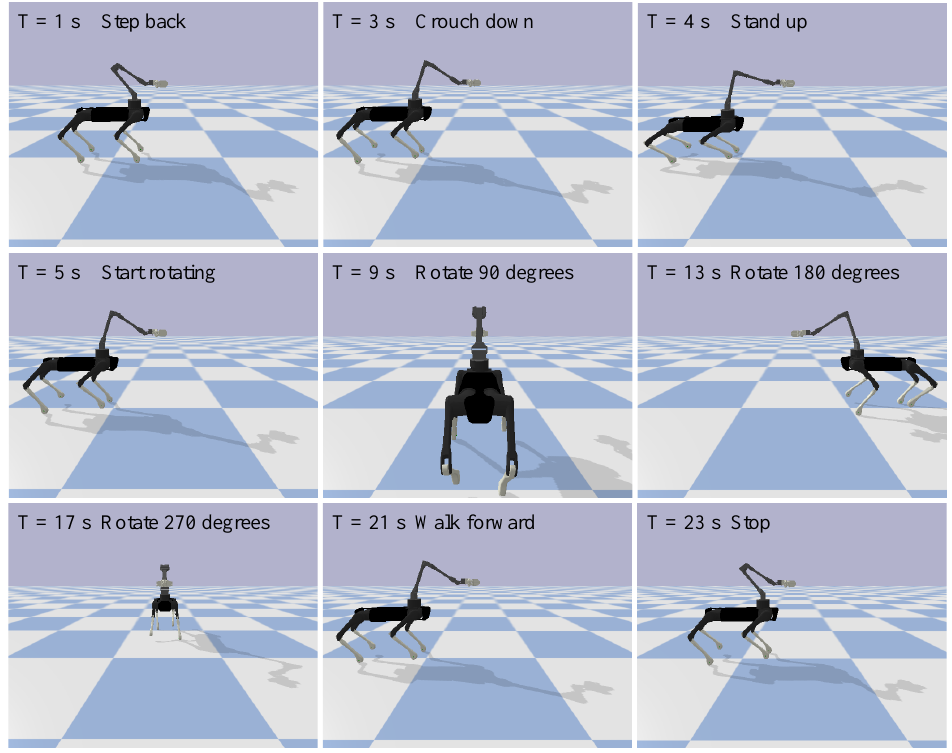
Figure 3. Snapshots of the robot performing walking pivot motion.